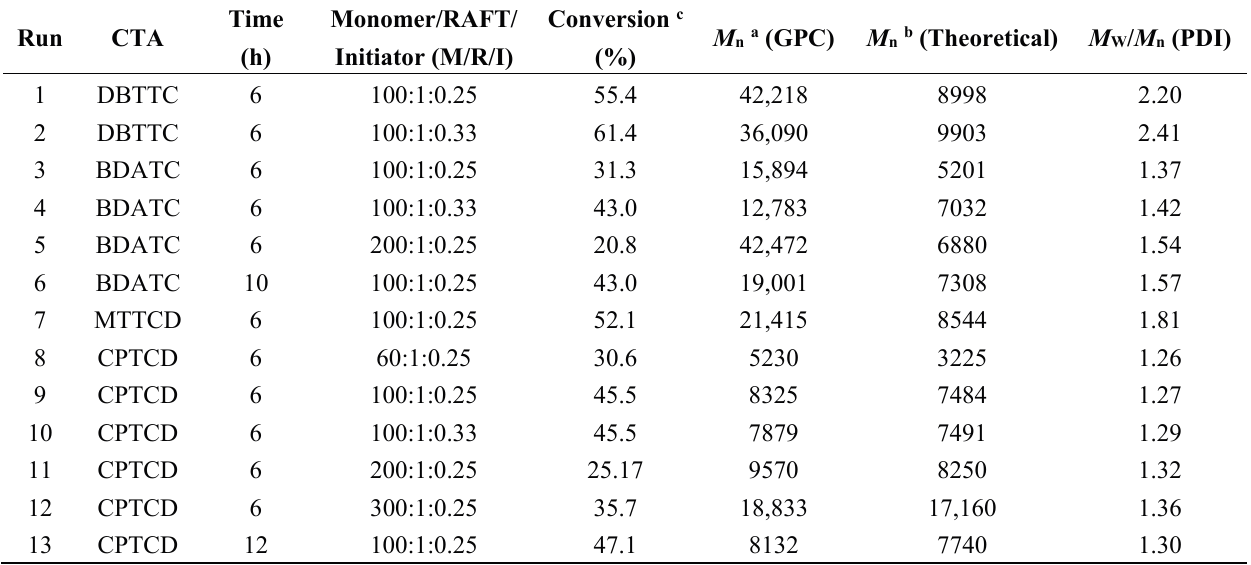
Table 1. RAFT polymerization results of DMAEMA in the presence of DBTTC, MTTCD, BDATC and